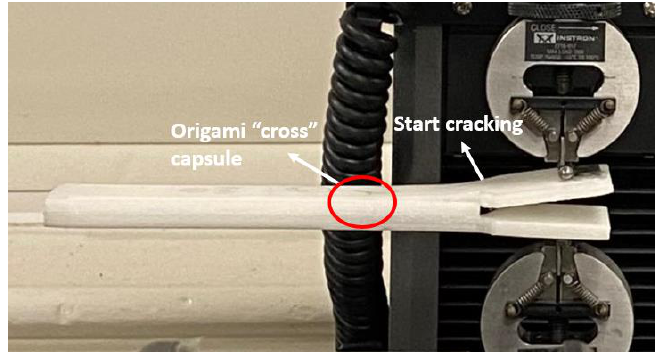
Figure 20. Measuring DCB crack length and displacement during the test.